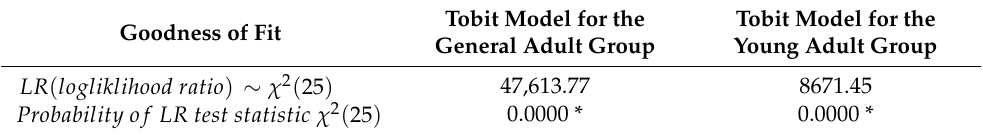
Table 4. Goodness of fit for the Tobit